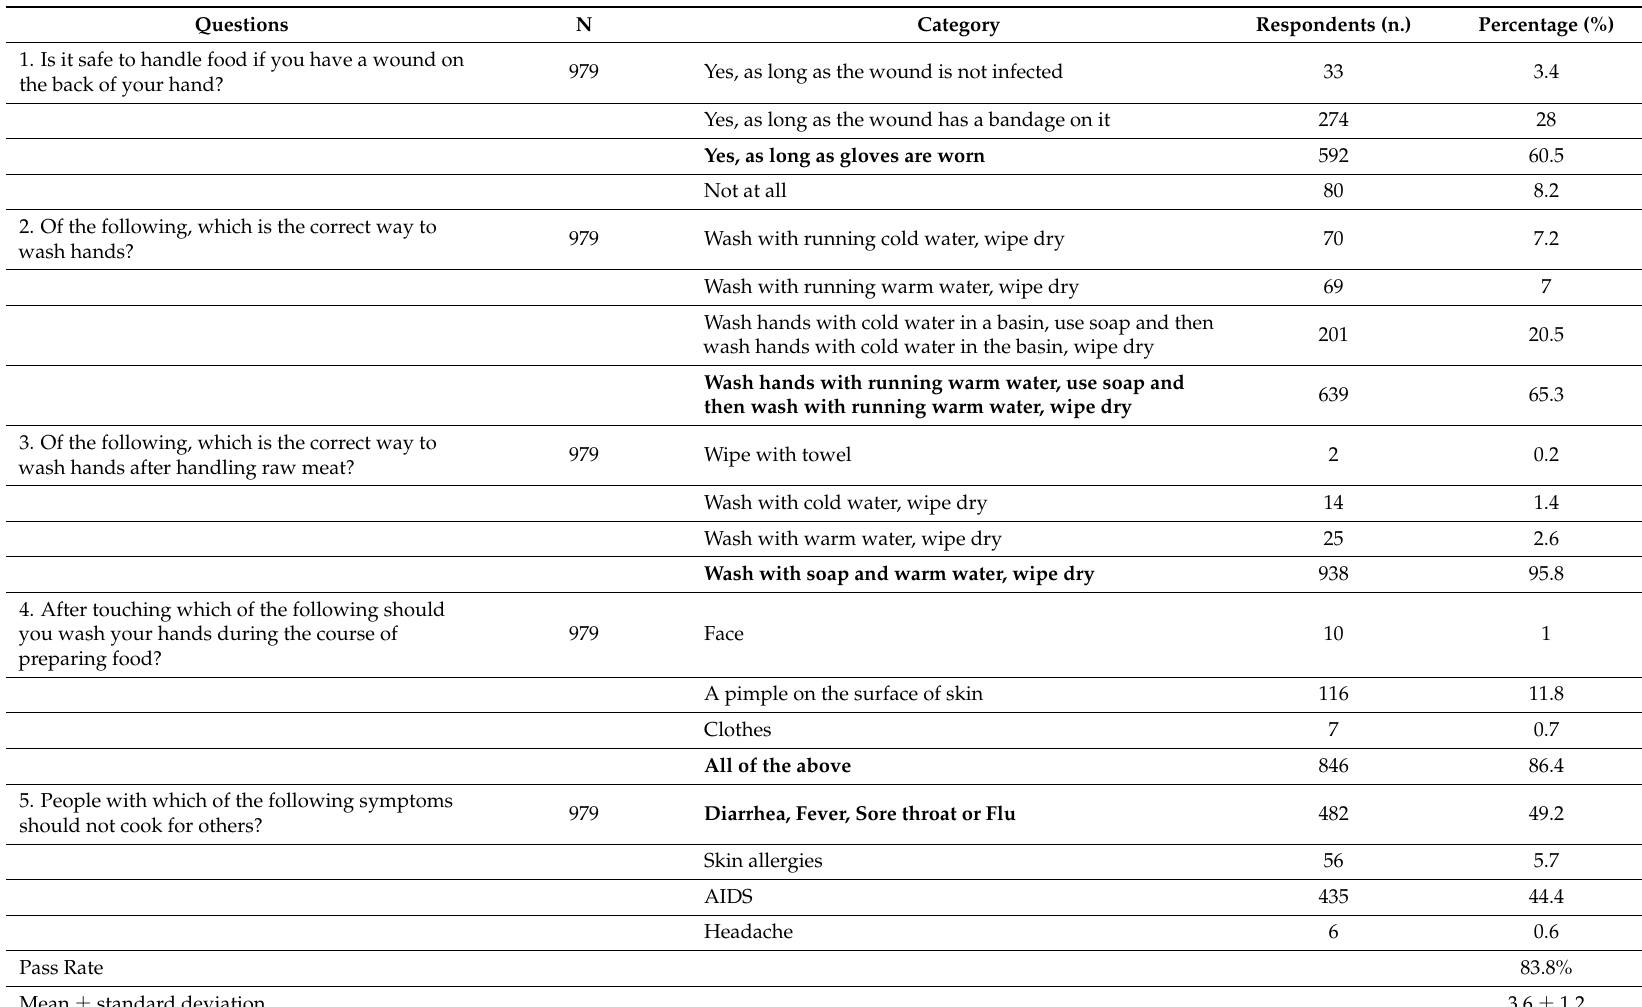
Table 5. Respondents knowledge on personal hygiene, pass rate, mean score, and standard